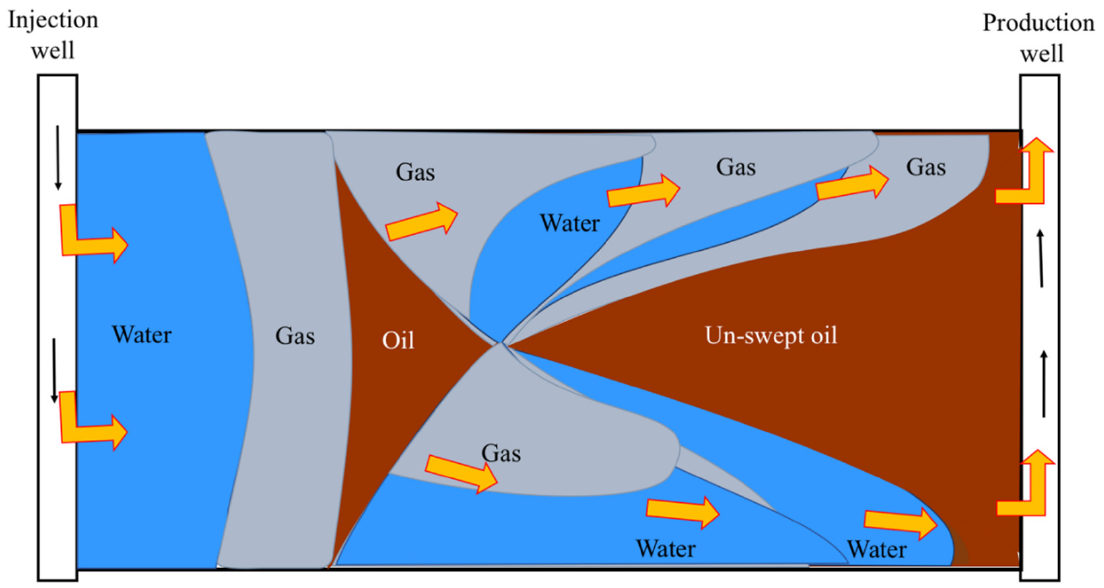
Figure 1. A WAG injection process and distribution of phases in a typical reservoir (Modified after [62] ).